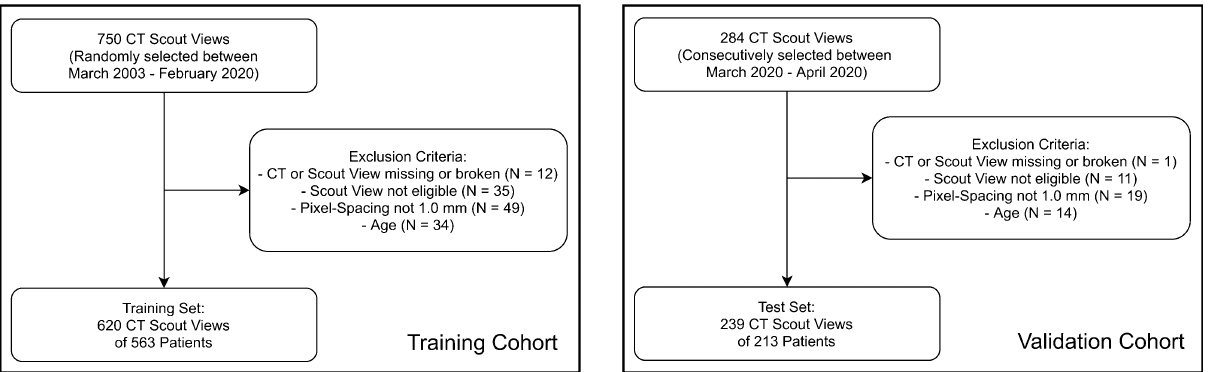
Figure 1. Patient flowchart for the training and the validation cohort with inclusion and exclusion